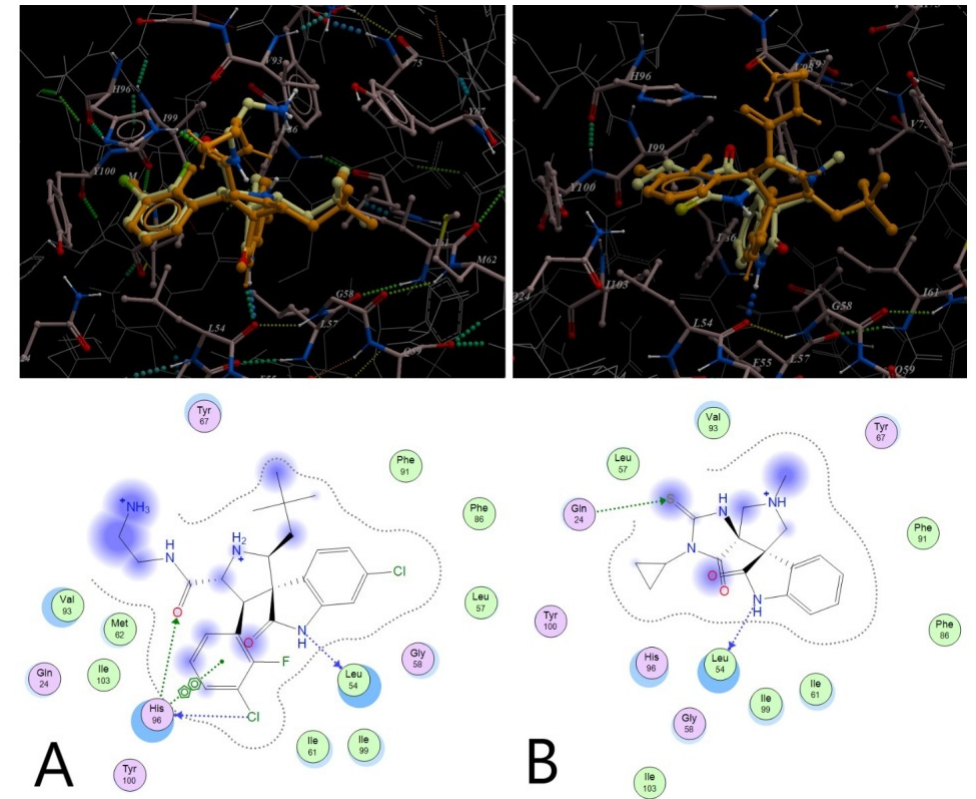
Figure 4. The results of moleculardocking study: ( A ) MDM2 inhibitor V (see Figure 3) bound in the target pocket (4JVR)—RSA data (orange), the predicted active conformation (yellow, E b = –88 kcal/mol), RMSD=0.23; ( B ) compound 4u (orange, E b = –53 kcal/mol) and the reference compound V (yellow) docked into the same binding site (the best conformations are shown).